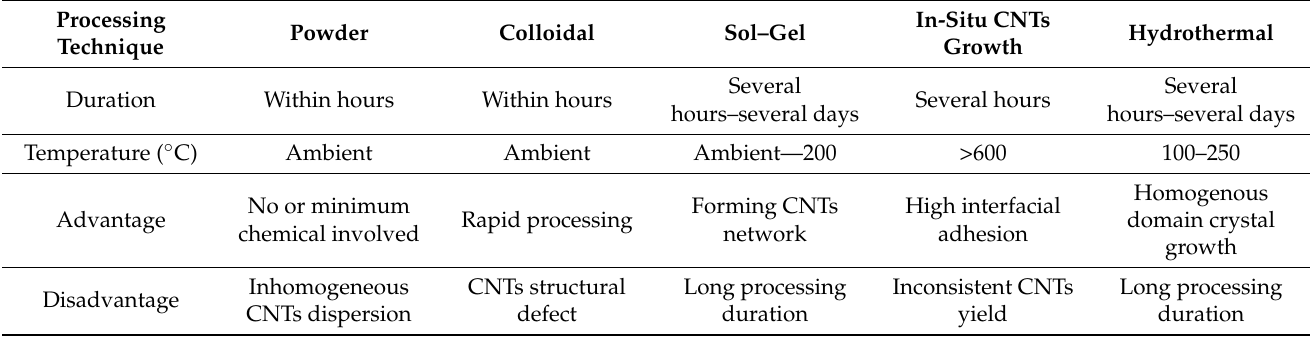
Table 12. Comparison table of processing methods.